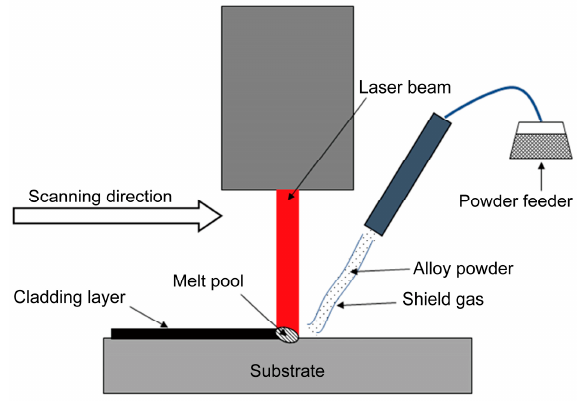
Figure 1. Schematic diagram of the laser cladding process.